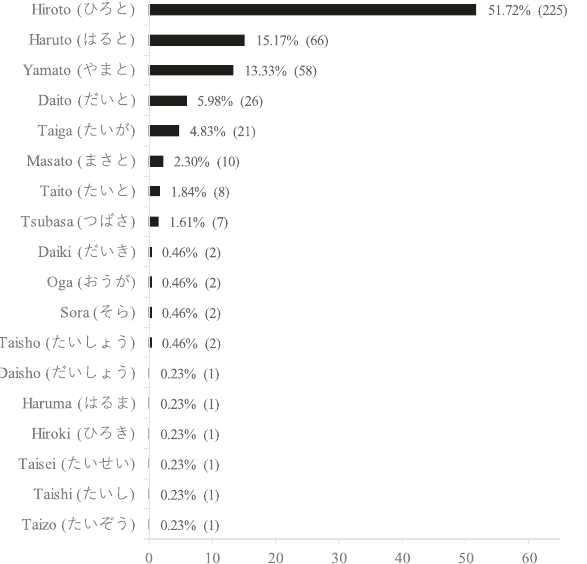
Fig. 1 Variations in readings of the name 大 翔 . Scores indicate relative frequencies of each reading among the sample ( n = 435). Scores in parentheses indicate the absolute frequencies of each reading.